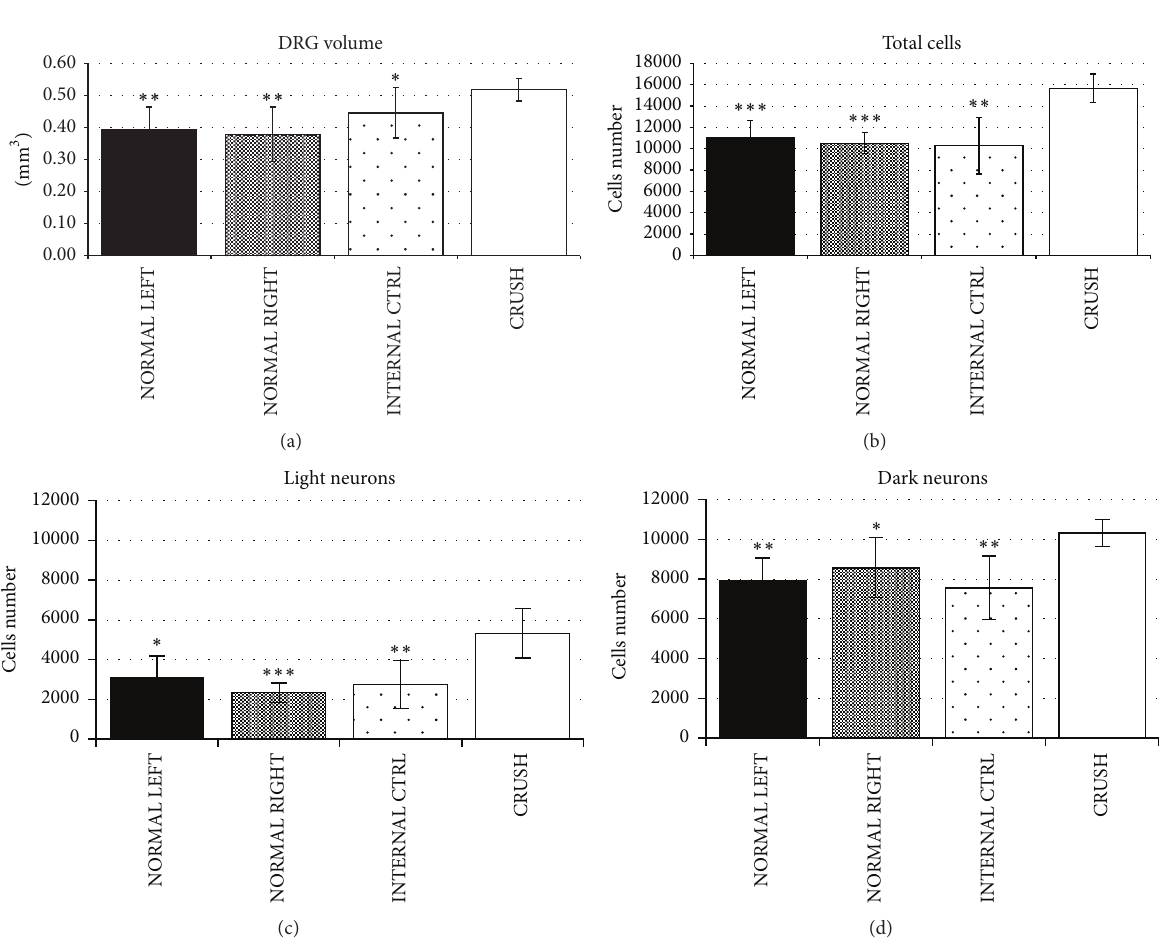
counting the number of neurons (considering their different cell sizes) within the ganglia, was applied.